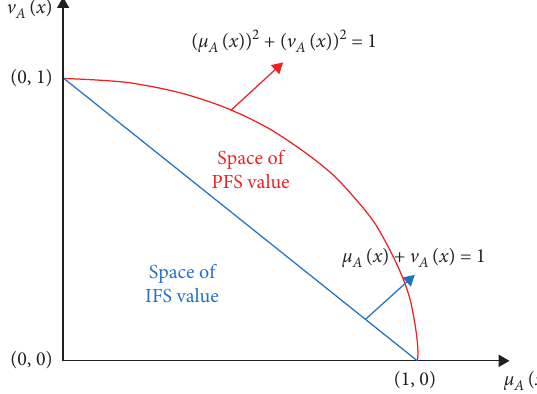
Figure 1: IFS and PFS applicable scope